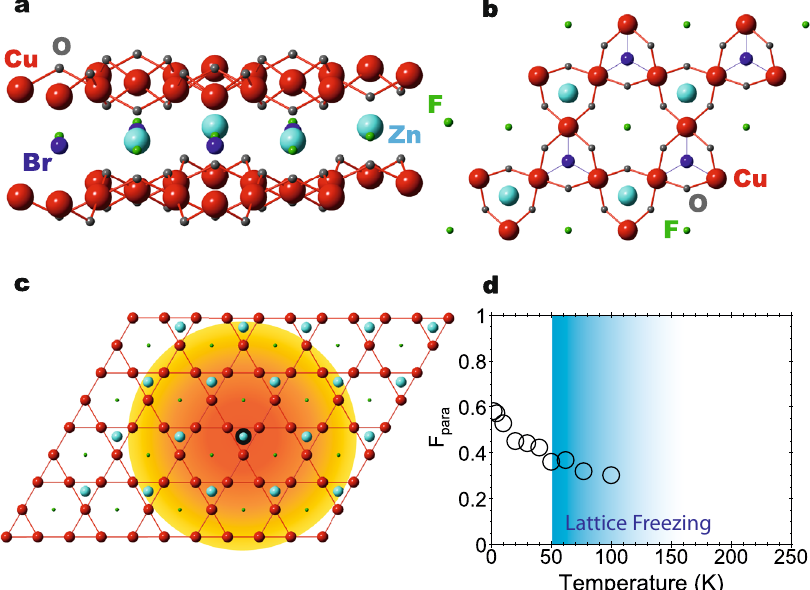
Fig. 1 Kagome lattice. a The crystal structure of Zn-barlowite “ Zn 0.95 ” (Zn 0.95 Cu 0.05 )Cu 3 (OD) 6 FBr. For clarity, D-sites attached to O-sites are not shown in any of the panels. b A c-axis view of the kagome plane of Zn 0.95 , and the interlayer Zn (cyan), Br (blue), and F (green) sites above and below the kagome plane. c A wider fi eld of view of the kagome plane in Zn 0.95 , without D, O, and Br sites. The Zn 2 + site surrounded by a black circle near the middle of the panel represents the Cu 2 + interlayer defect occupying one of the twenty Zn sites within this fi eld of view with a 5% probability. The circle with orange-to-yellow shading represents the spin-polarized domains, which encompasses 12 of the 20 19 F sites in this fi eld of view, corresponding to 60% as observed at 2 K in panel d . All the kagome Cu sites in this domain have polarized spins or interact with them. d Temperature dependence of the fraction F para of the 19 F sites belonging to the spin-polarized domains estimated in this work. Blue shading depicts the freezing of the lattice distortion starting at ~160 K and completing at ~50 K 21 temperature roughly in proportion to the bulk averaged spin susceptibility χ bulk15,17 . This means that the interlayer defect moments, which are polarized by the external magnetic fi eld B ext applied to conduct NMR measurements, induce a negative hyper fi ne magnetic fi eld B hyp pointing in the opposite direction